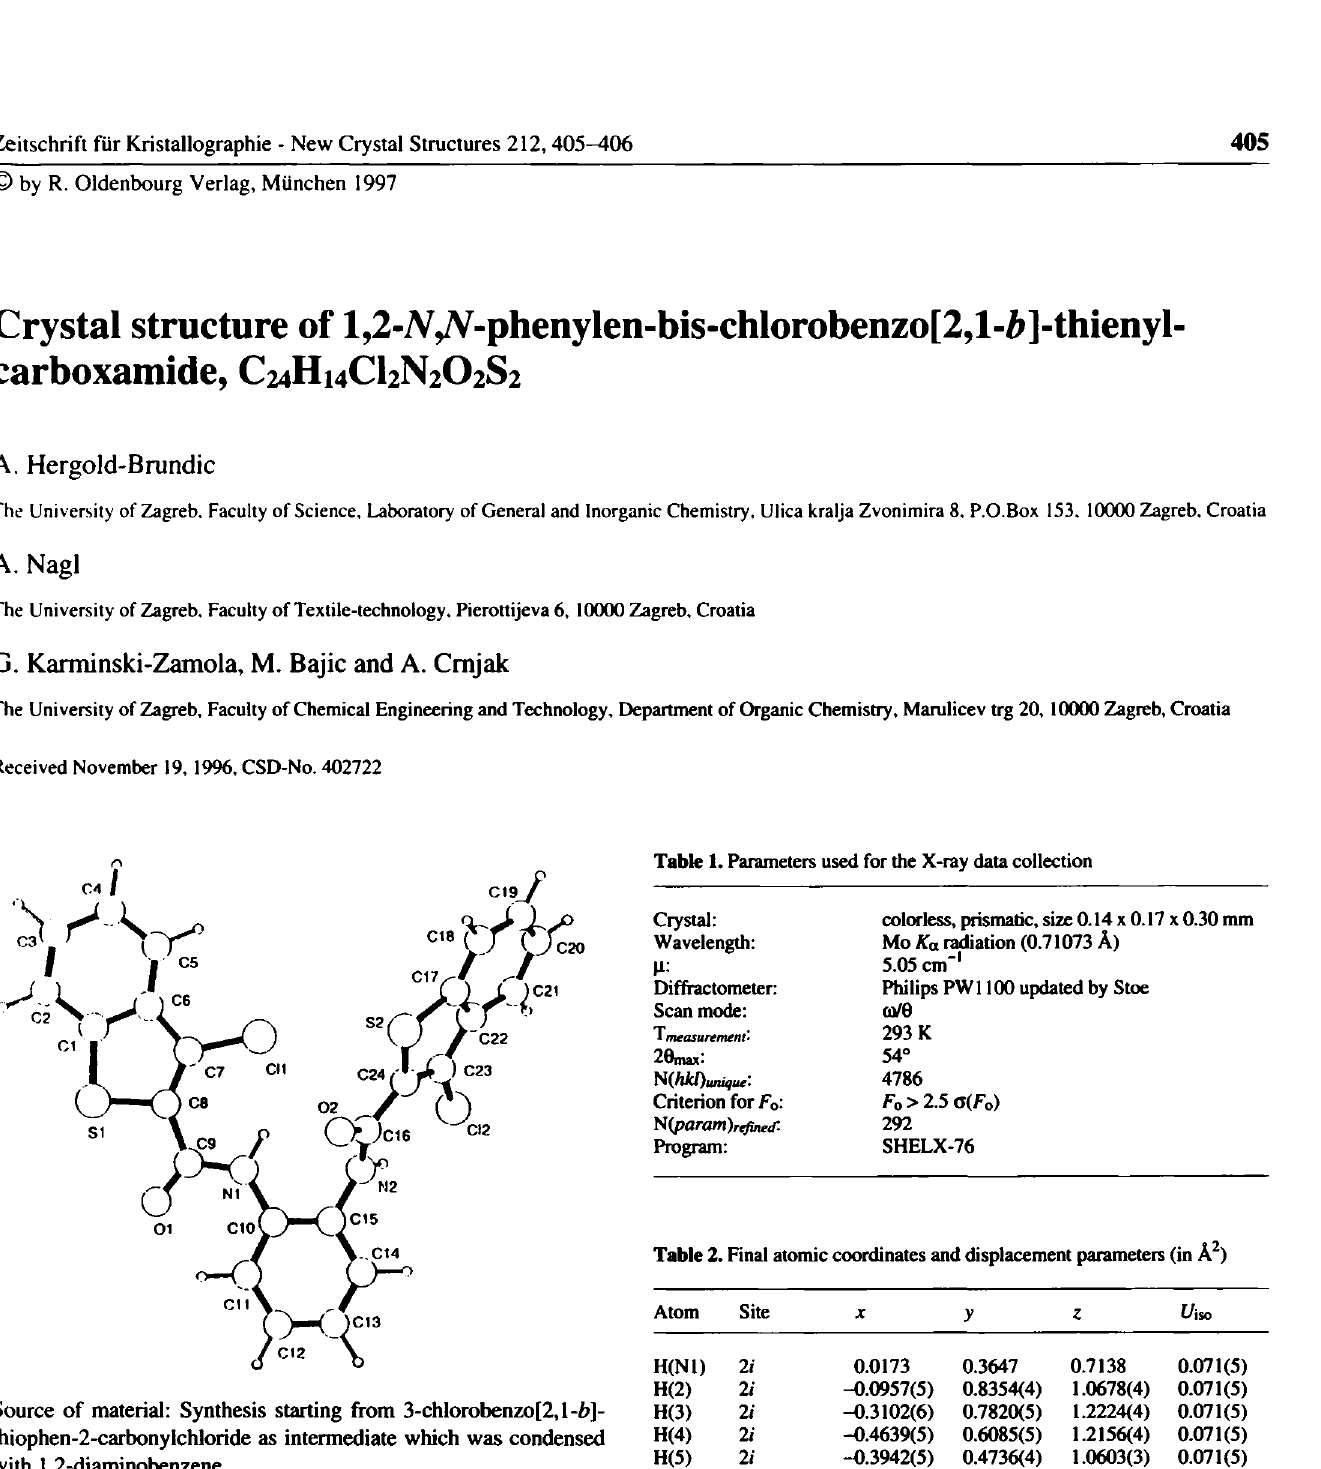
Table 2. Final atomic coordinates and displacement parameters (in Â 2 )